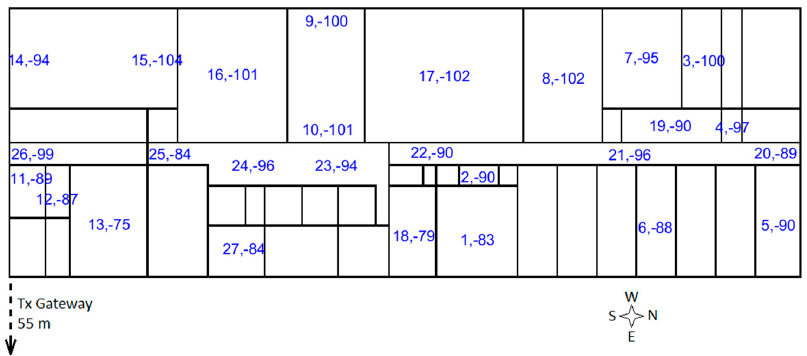
Figure 2. Indoor structural layout of eighth floor, sampling locations, and their corresponding received signal strength indicators (RSSI).